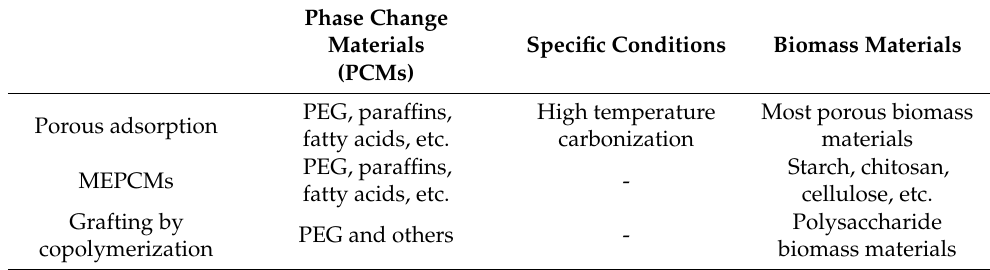
Table 4. The applicable methods for different types of PCMs and biomass materials and the spe- cific